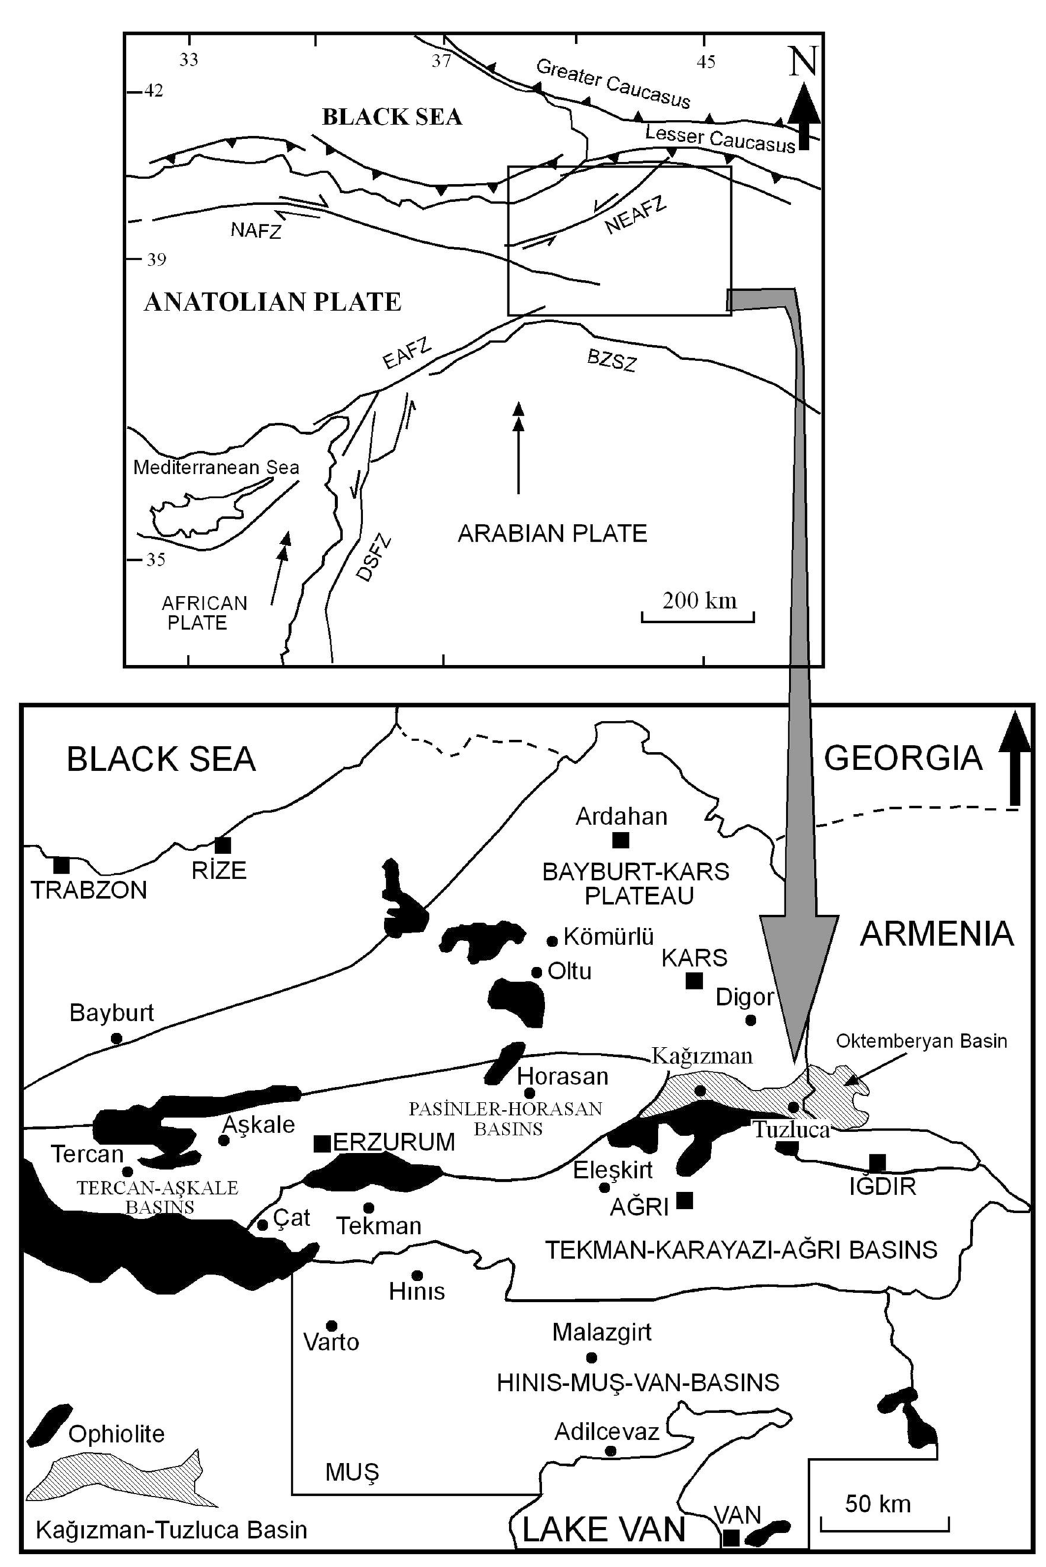
Fig. 1 Location map of the Eastern Anatolian subbasins ( DSFZ Dead Sea Fault Zone, NAFZ North Anatolian Fault Zone, NEAFZ Northeast Anatolian Fault Zone, EAFZ East Anatolian Fault Zone, BZSZ Bitlis-Zagros Suture Zone (modified from Bozkurt 2001; Şahintürk et al.